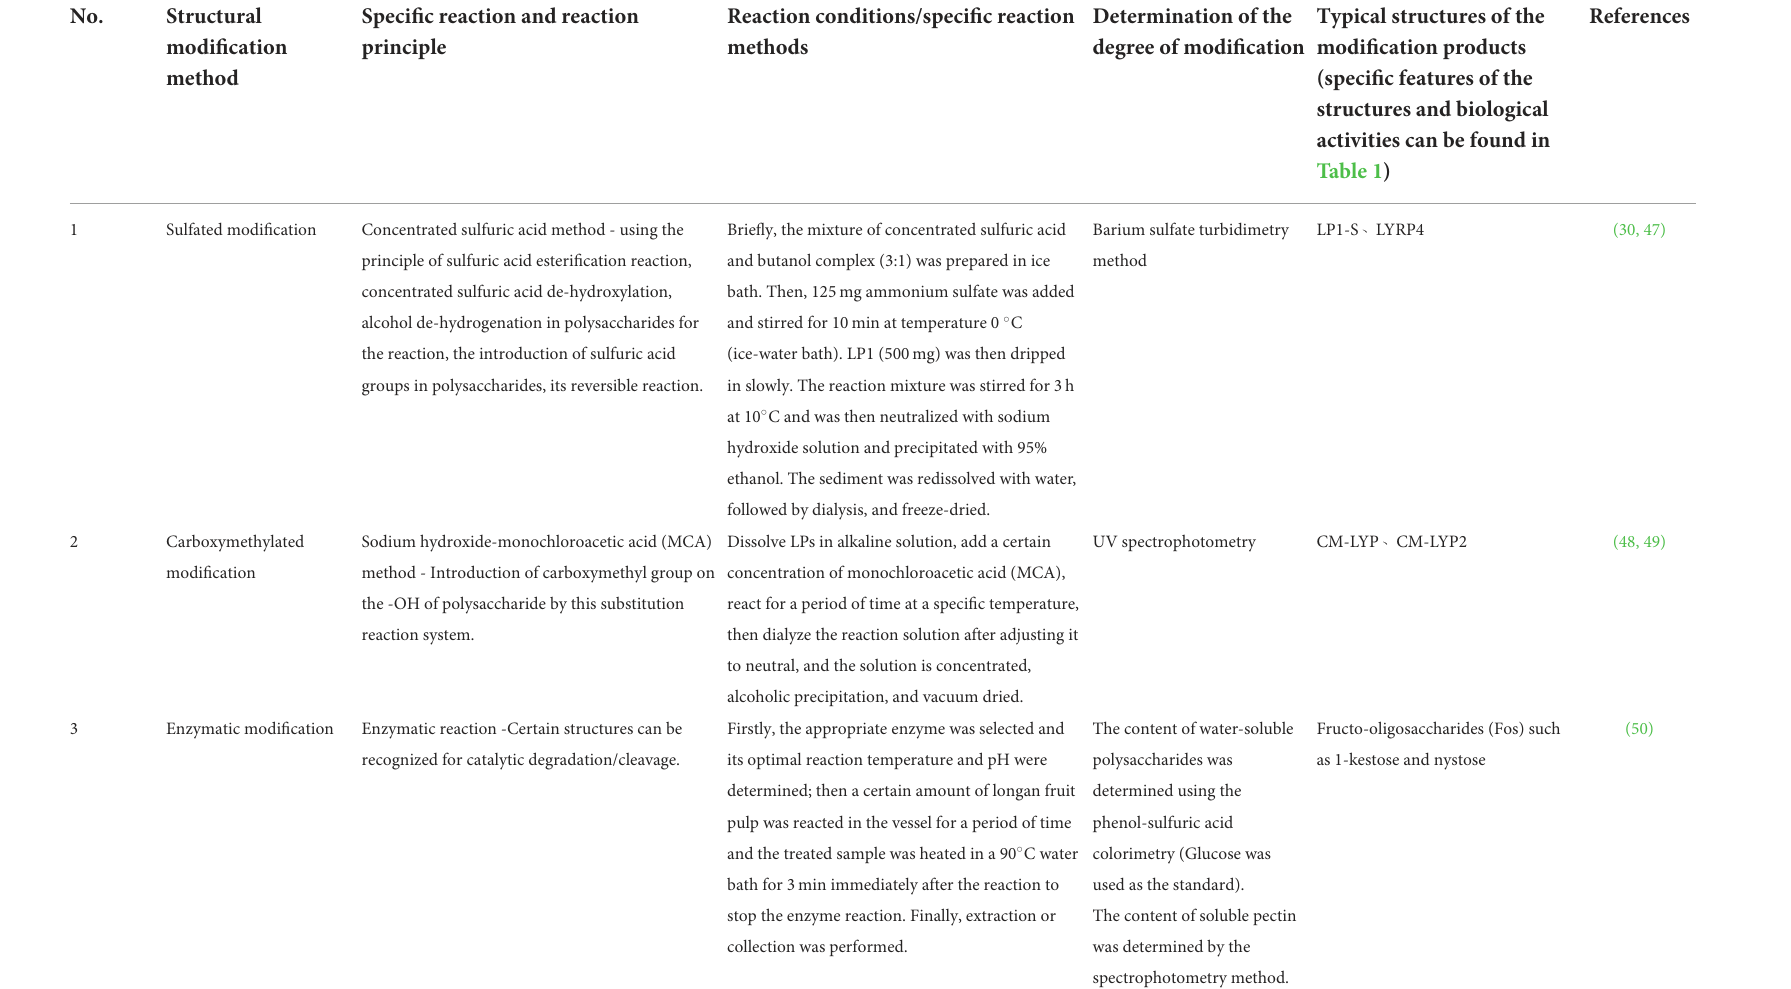
TABLE 2 The modification approaches, containing reaction conditions, reaction principles and typical structures of modification products for different structural modifications.